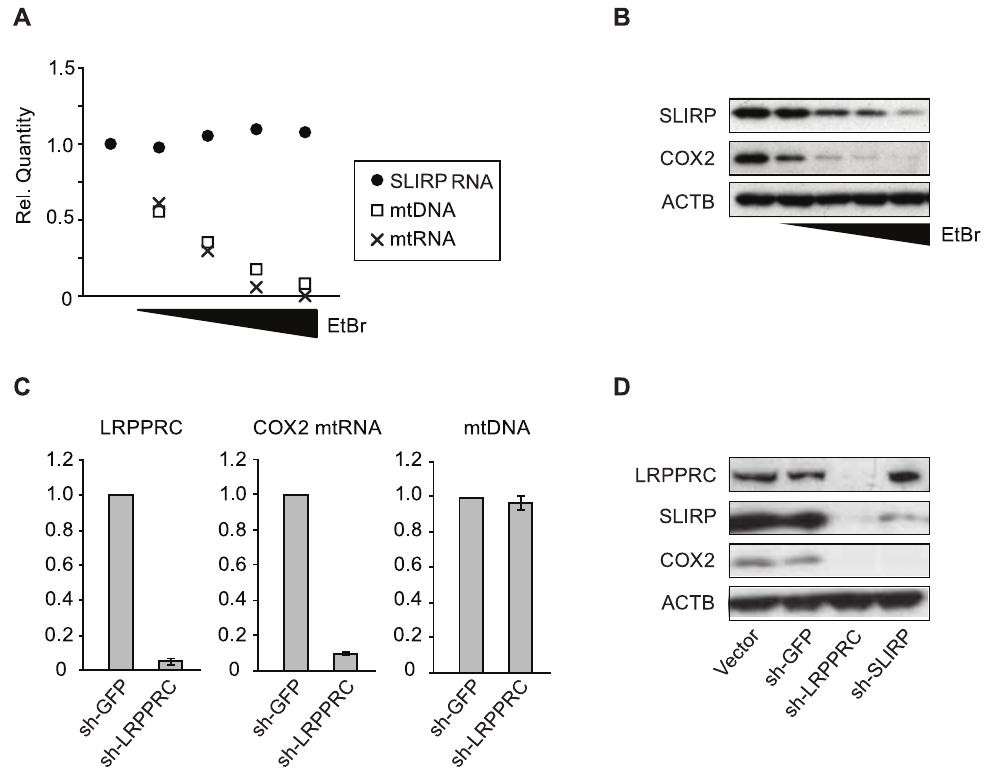
Figure 6. SLIRP depends upon mitochondrial mRNA for stability. (A) mtDNA copy-number, mtND2 expression (mtRNA), and SLIRP expression measured by qPCR from MCH58 cells depleted of mtDNA for 4 days in the presence of 2.5, 5, 10, or 20 ng/ml ethidium bromide. (B) Western blot of SLIRP, COX2, and ACTB protein abundance for the samples in (A). (C) mtDNA copy-number and mRNA expression of COX2 and LRPPRC in MCH58 cells infected with shRNA targeting LRPPRC or a GFP control. Mean ratios over shGFP cells are reported (n=3). (D) Western blot of protein lysates from shGFP-, shSLIRP-, and shLRPPRC-infected cells 10 days post-infection.